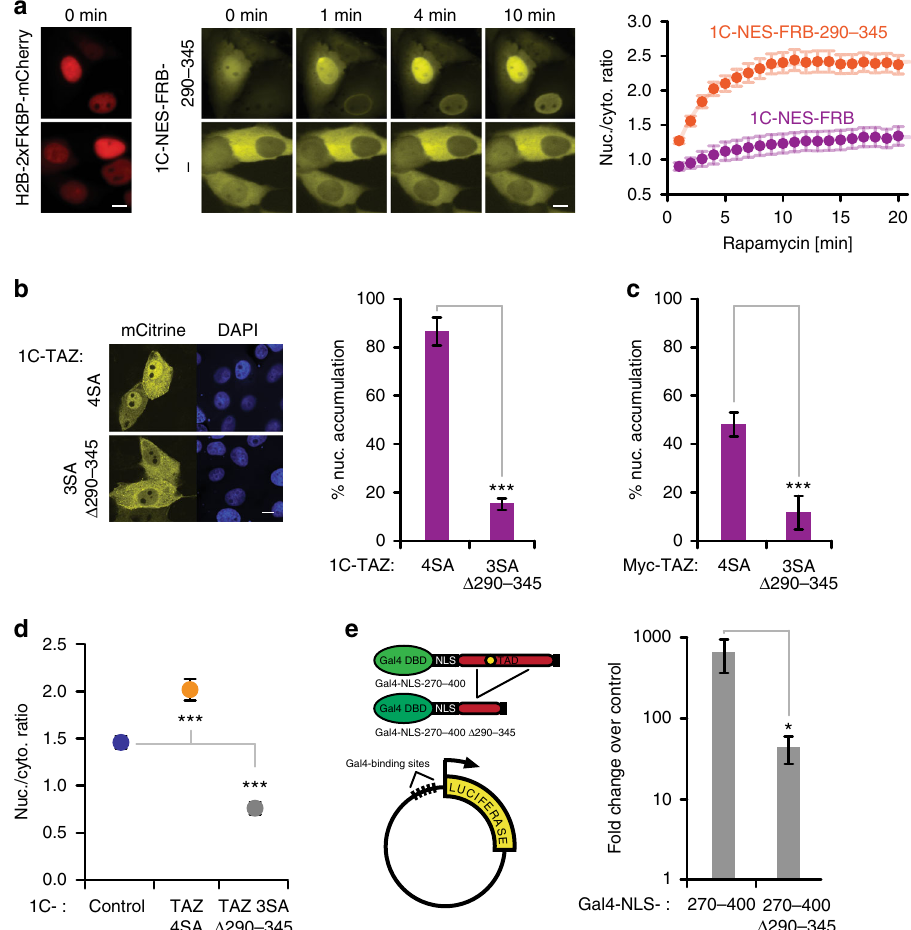
Fig. 4 The TAZ-NLS is functionally relevant in the context of small constructs. a Live-cell RIS ’ N import assay. Fluorescence images were recorded using a Viva View system and show co-expression of H2B-2xFKBP-mCherry (red) and 1C-NES-FRB or 1C-NES-FRB-290 – 345 (yellow) at indicated time-points (left). Scale bar: 10 μ m. Average R N/C values ± SEM were plotted against time of rapamycin treatment. 1C-NES-FRB, n = 40 cells; 1C-NES-FRB-290 – 345, n = 80 cells. Differences between the two probes are signi fi cant at all time-points ( p < 0.01, not indicated). Curves are fi ts to an exponential rise to maximum function. b Confocal fl uorescence microscopy images of LLC-PK1 cells expressing 1C-TAZ constructs (4SA and 3SA Δ 290 – 345; yellow), with DAPI stain (blue). Scale bar: 10 μ m. Right: Visual quanti fi cation of cells with nuclear enrichment. Data are presented as means ± SD, n = 4. c Myc-tagged TAZ constructs (4SA and 3SA Δ 290 – 345) were detected by immuno fl uorescence staining using an anti-Myc antibody and nuclear enrichment was determined by visual counting. Data are presented as means± SD, n = 4. d Median R N/C values of 1C-control, and indicated 1C-TAZ constructs. Data are presented as means ± SD, n = 3 or 6 for individual constructs. e Luciferase reporter system. Gal4-NLS-TAZ TAD constructs drive the expression of fi re fl y luciferase from a plasmid with fi ve Gal4 binding sites in the promoter region, shown on the left. Luciferase activities, normalized to the transfection control Renilla-TK, are shown as fold changes relative to the activity obtained from a Gal4-NLS-mCherry driven expression. Data are presented as means ± SD, n = 4. * p < 0.05, *** p < 0.001; Student ’ s t